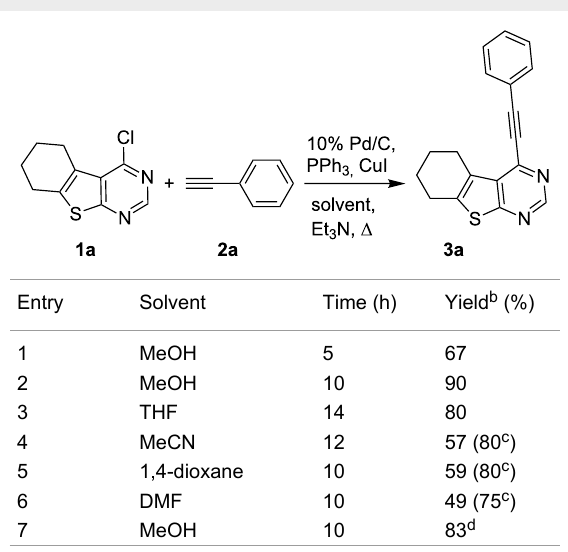
Table 1: Effect of solvent on the coupling reaction of 4-chloro-5,6,7,8- tetrahydrobenzothieno[2,3- d ]pyrimidine ( 1a ) with phenylacetylene ( 2a ).